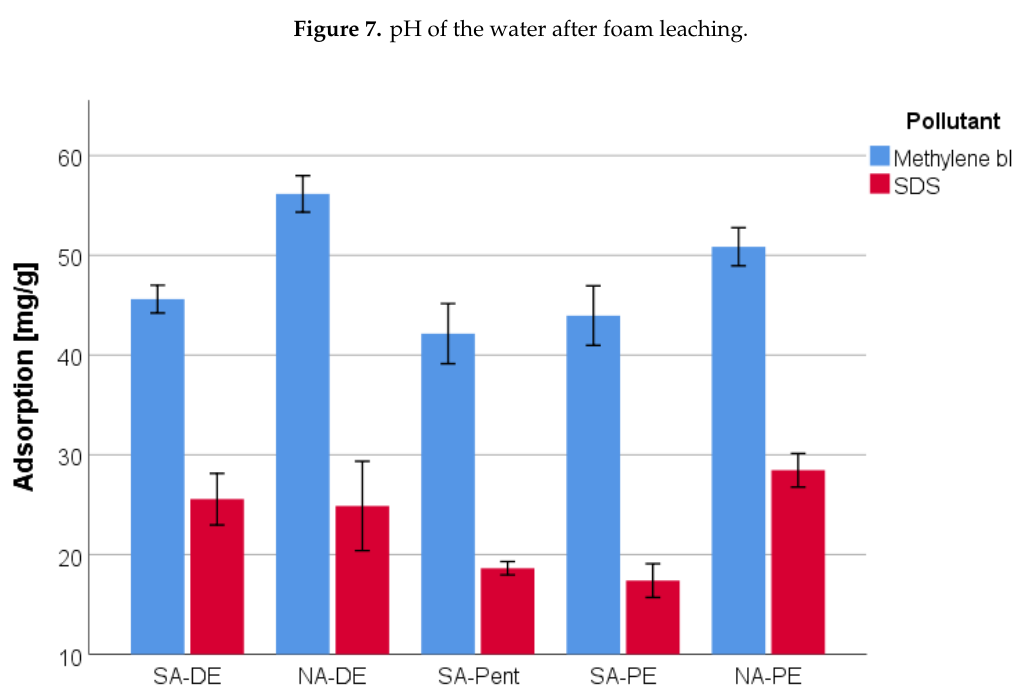
Figure 8. Pollutant adsorption of tannin foams.